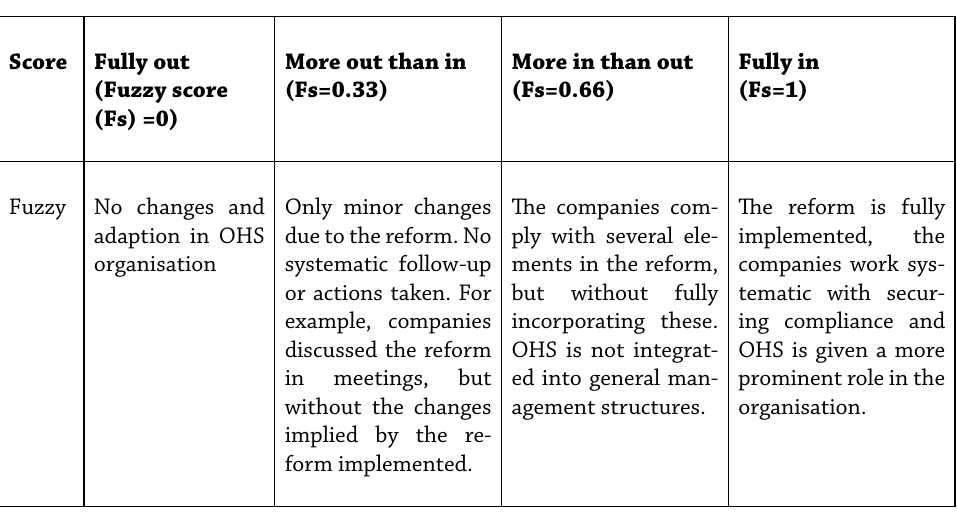
Table 1: Calibration of outcome Score Fully out